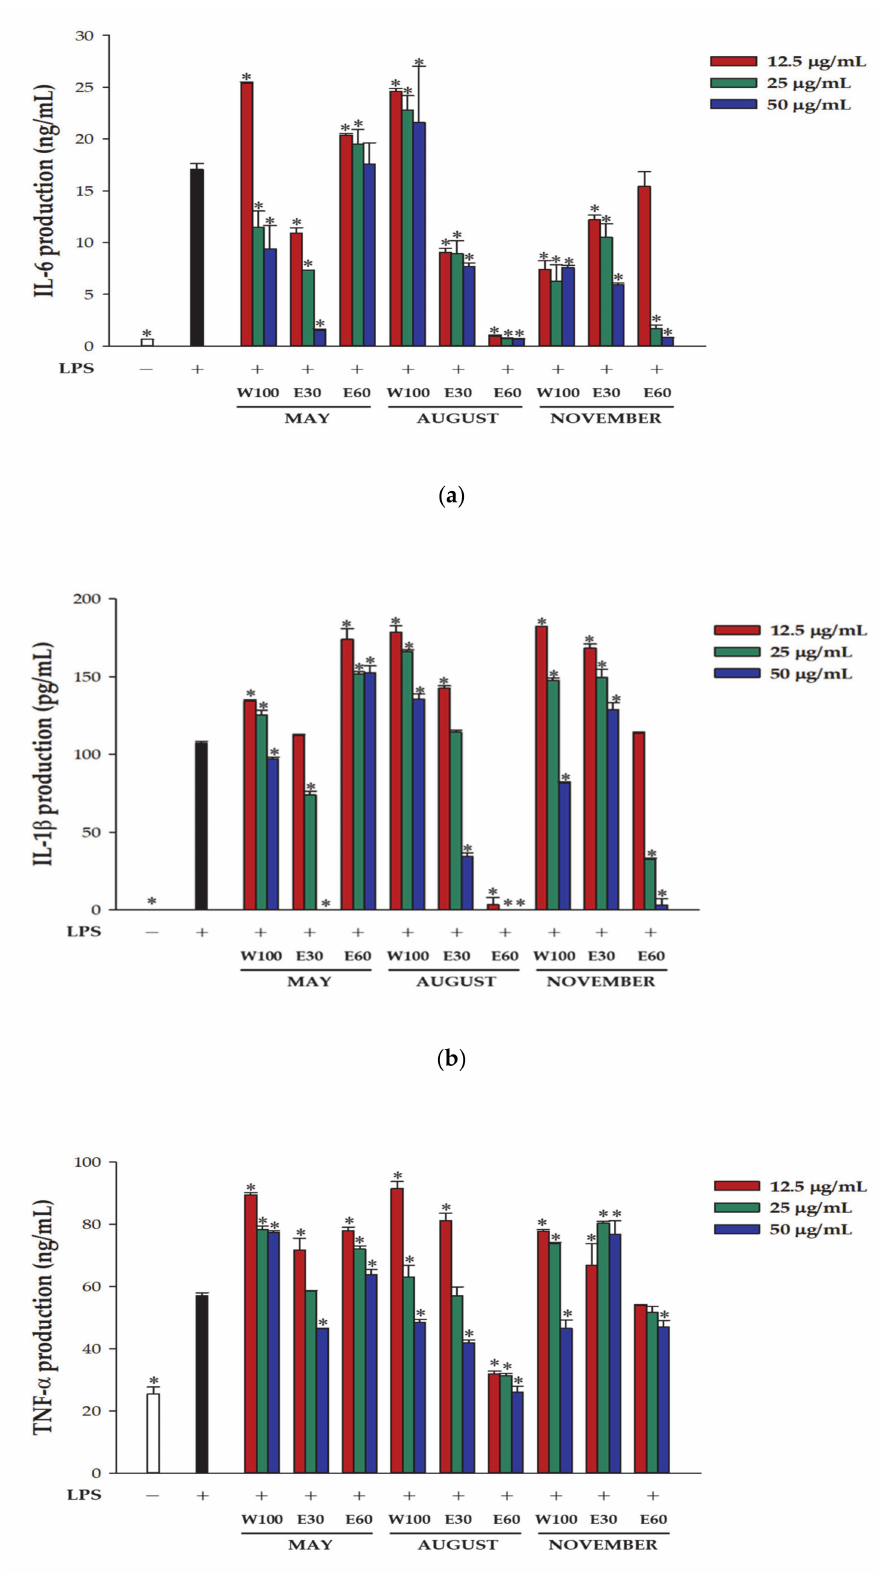
Figure 4. Concentration profiles of interleukin (IL)-6 ( a ), IL-1 β ( b ), and tumor necrosis factor- α (TNF- α ) ( c ) in the RAW264.7 cells stimulated with lipopolysaccharide. W100, hot water extracts; E30, 30% ethanol extracts; and E60, 60% ethanol extracts. Data are presented as the mean ± SEs of triplicate determinations of independent wells. Statistical analysis was performed using one-way ANOVA. *, p < 0.05 compared to the LPS-treated